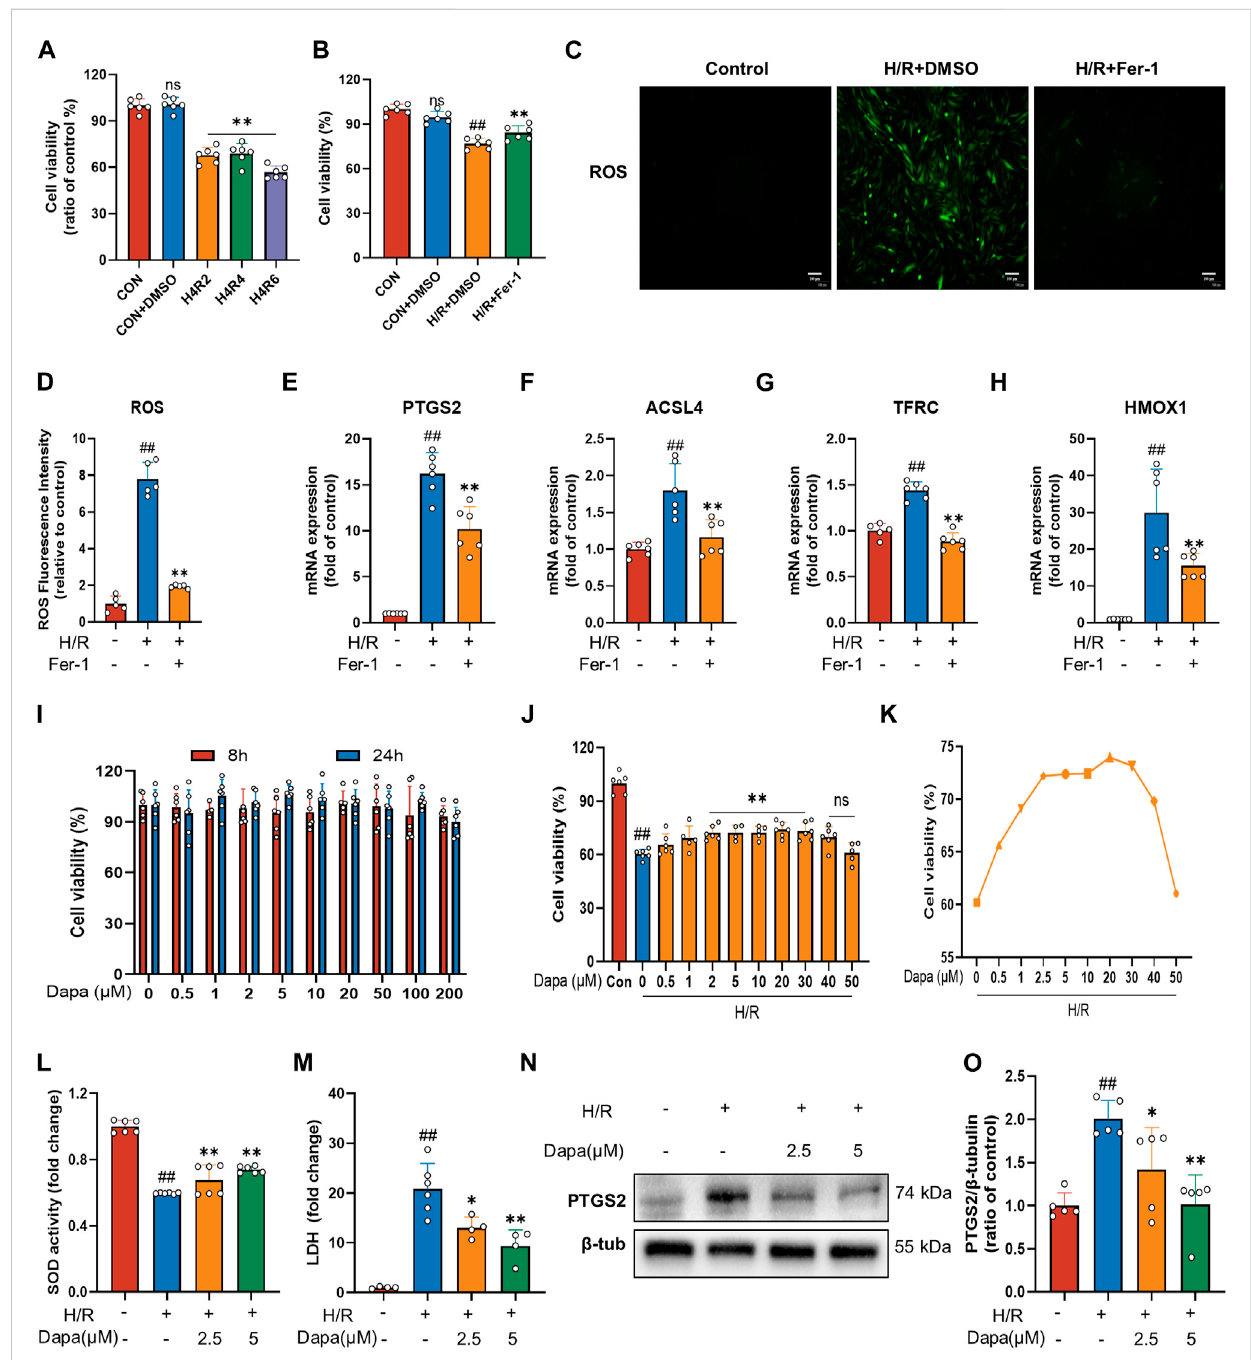
FIGURE 1 Dapagli fl ozinprotectsH9C2cellsagainstH/R-triggered cellinjury. (A) ViabilityofH9C2cellstreatedwithhypoxiafor4 handreoxygenation for2,4, 6 h. Cell viability was detected by CCK-8 assay ( n = 6 per group). (B) Ferrostatin-1 (Fer-1; 2 μ M) attenuates H/R-induced cell death. Cell viability was detected by CCK-8 assay ( n = 6 per group) (C) Representative fl uorescent images of ROS staining by using DCFH-DA (scale bar, 100 μ m), (D) and quanti fi cation of ROS fl uorescence intensity ( n = 5 per group). (E – H) RT ‒ qPCR results of PTGS2, ACSL4, TFRC and HMOX1 inH9C2 cells pretreated with Fer-1 and subjected to H/R ( n = 6 per group). (I) Effects of DAPA administration for eight or 24 h on the survival of H9C2 cells detected by CCK-8 assay(n=6pergroup). (J) EffectsofDAPAtreatmentonH/R-inducedcelldeathdetectedbyCCK-8( n =6pergroup). (K) H/R-inducedcellviability(%)of DAPA at different concentrations, cell viability was detected by CCK-8 assay ( n = 6 per group). (L) Measurement of SOD activity by a commercial kit ( n = 6 per group). (M) Total cellular LDH release was measured by a commercial kit ( n = 4 – 6 per group). (N – O) Western blot analysis of PTGS2 in H9C2 cells after treatment with DAPA (2.5 or 5 μ M) ( n = 5 per group). Data are expressed as mean ± SD; Statistical analysis: One-way ANOVA followed by Tukey ’